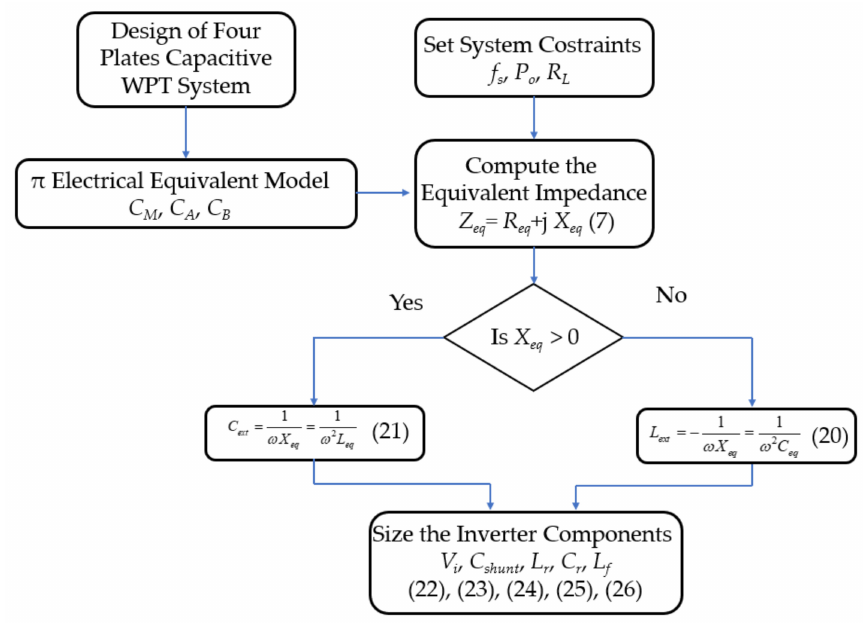
Figure 6. Design procedure flowchart representation.